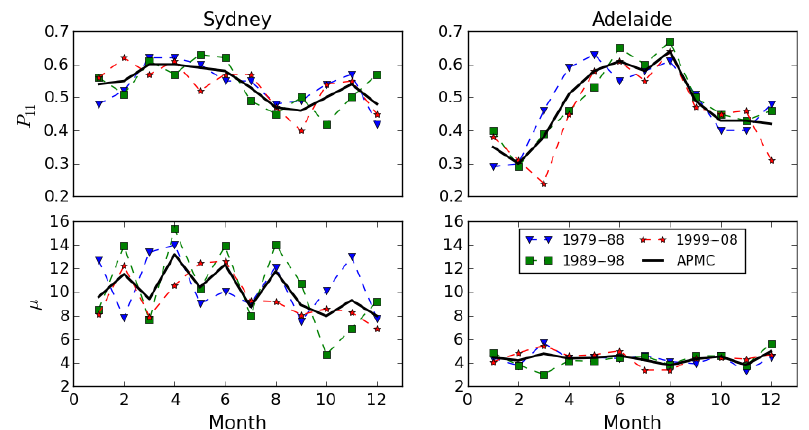
Figure 2. Comparison of the decadal variability of the DPMC parameters P 11 and µ (mm) with the APMC